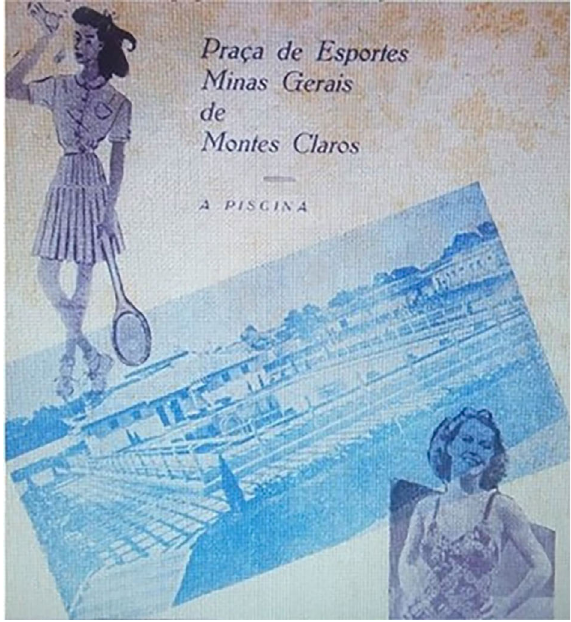
Figure 5 - Advertisement of the Sports Square in 1941. Source: Revista Montes Claros (Minas Gerais), No. 5, November 1941, p.